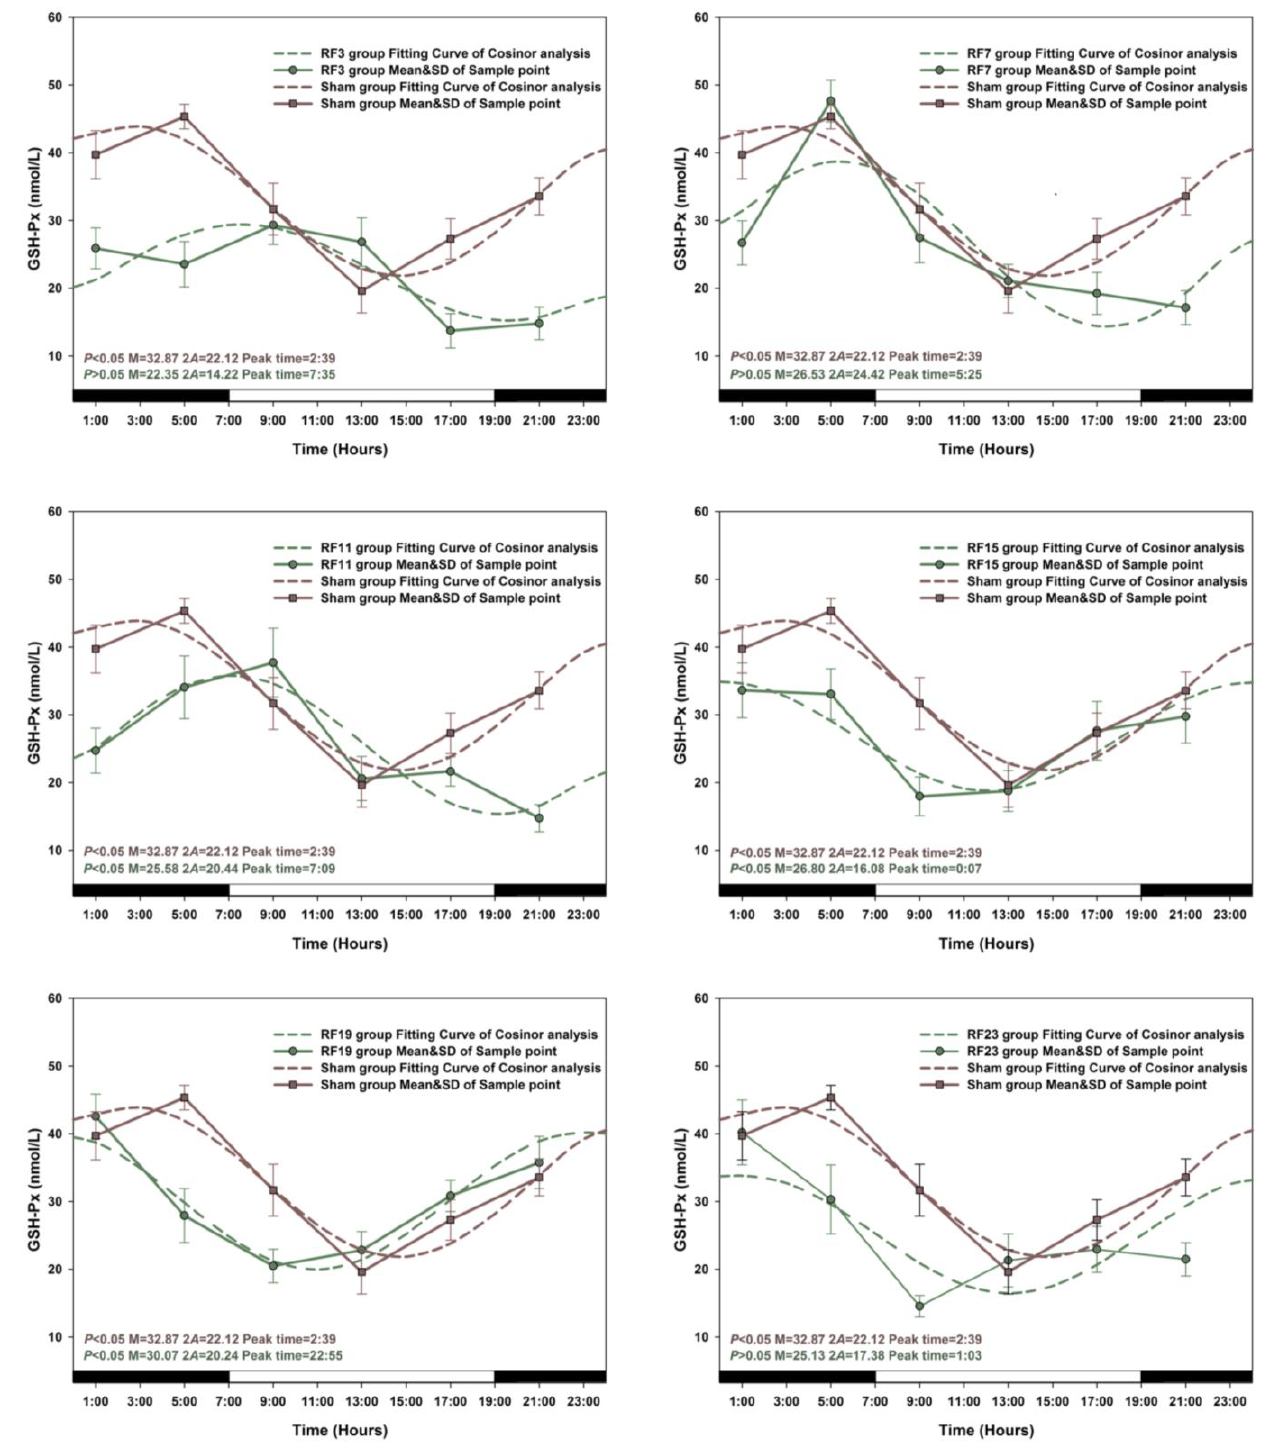
Figure 5. The best-fitting curves (means ± standard error) determined for GSH-Px in RF and Sham-exposed rats. Y-axis represents GSH-Px concentration in the plasma; x-axis represents the Time during the 24 h light-dark cycle. For time-effect, p values from Zero-amplitude test, as well as the median (M), the double amplitude (2A) and the time of peak phase (Peak time) of the 24 h cosine curves, are listed. The circadian rhythm is regarded as significant when p <